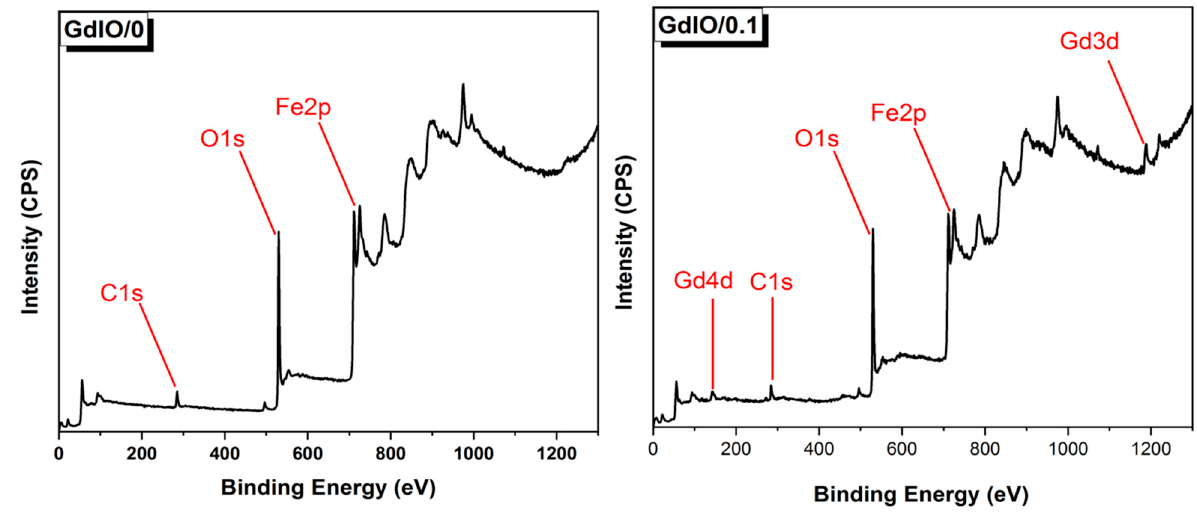
Figure 3. XPS spectra for Gd IO/0 ( left ) and Gd IO/0.1 ( right ).